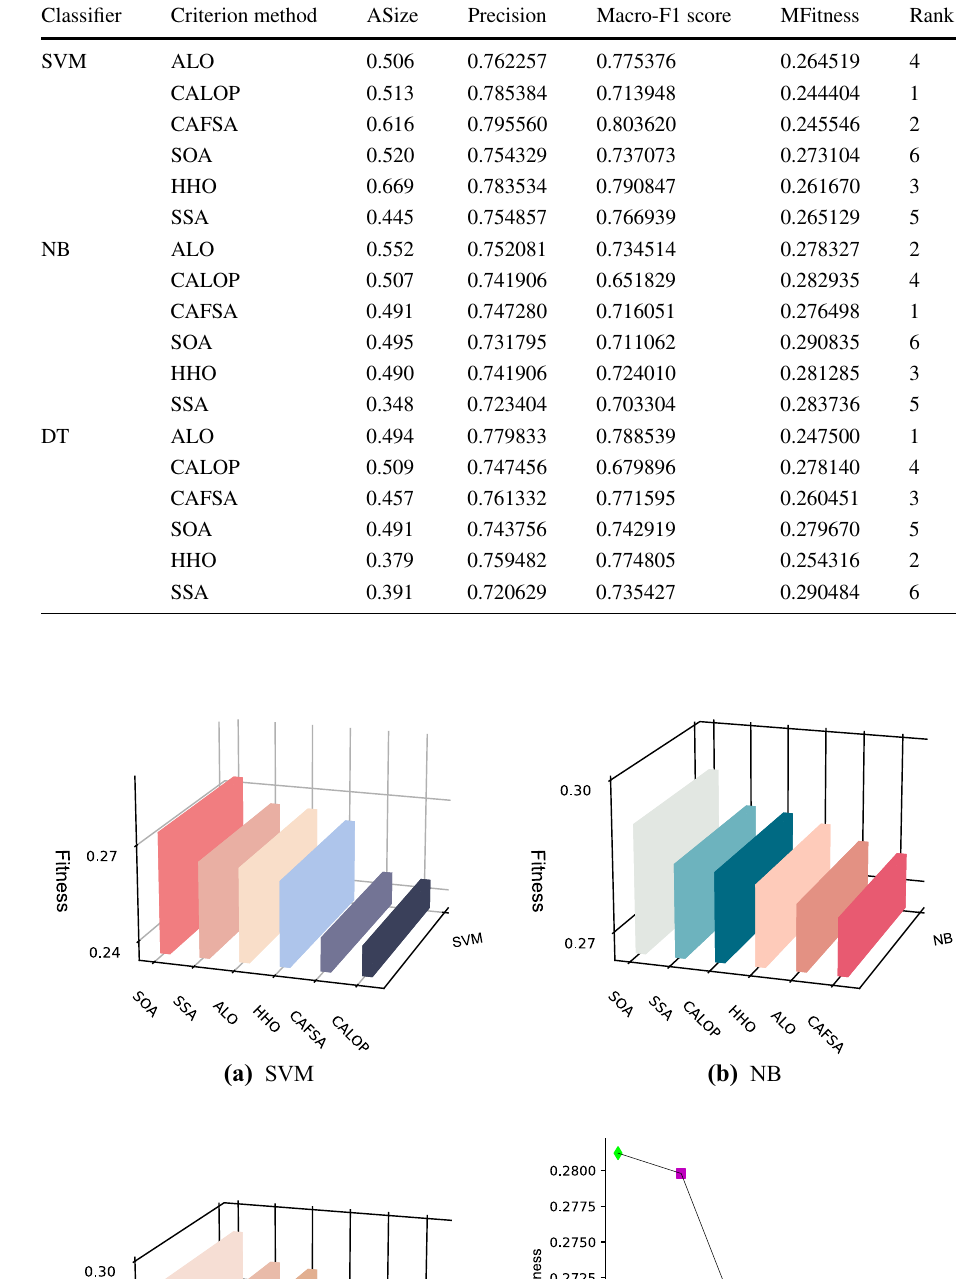
Table 7 Experimental results of six intelligent algorithms on the SoGouCS news data set